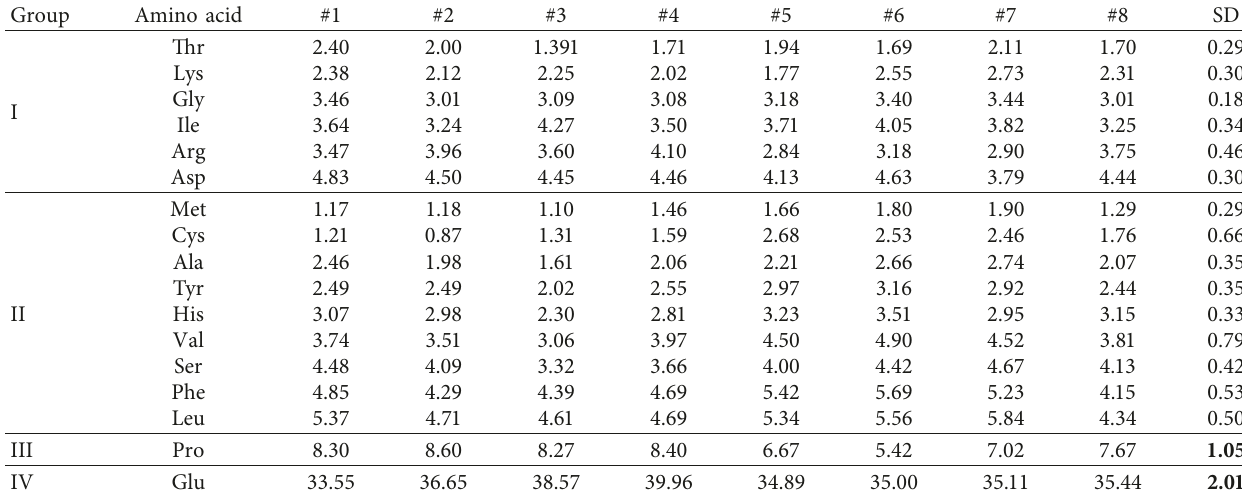
Figure 3: The content of protein composition of flour particles of different sizes. (a) albumin content; (b) globulin content; (c) gliadin content; (d) glutenin Table 3: Amino acid content of flour particles of different sizes (percentage of total protein).